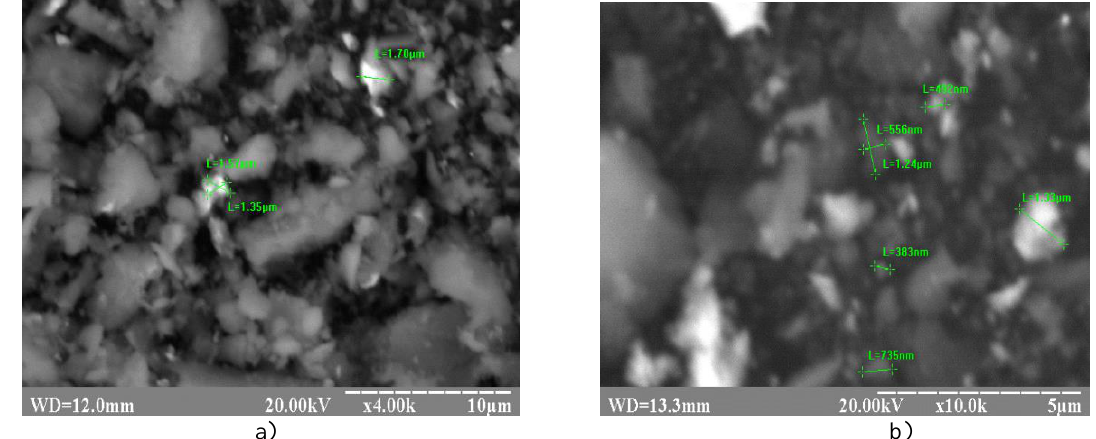
Fig. 2. SEM image of SiC-Al 2 O 3 composite powders after mixing and grinding in steel vessels by steel milling bodies for 32 hours; a – 4000 zoom; b – 10,000 zoom. (250-400 nm particles are